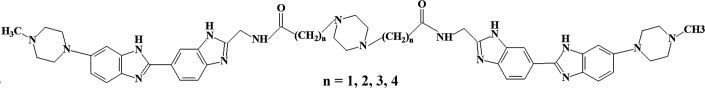
Symmetric dimeric bisbenzimidazoles; bisbenzimidazole fragments joined by oligomethylene linkers with a central 1,4-piperazine residue (DBP(1–4)).